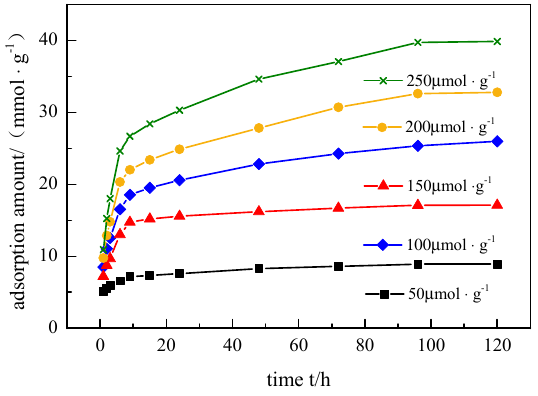
Figure 6. E ff ect of bisphenol A (BPA) + sulfamethoxazole (SMX) adsorption time on Figure 6. Effect of bisphenol A (BPA) + sulfamethoxazole (SMX) adsorption time on adsorption adsorption performance.